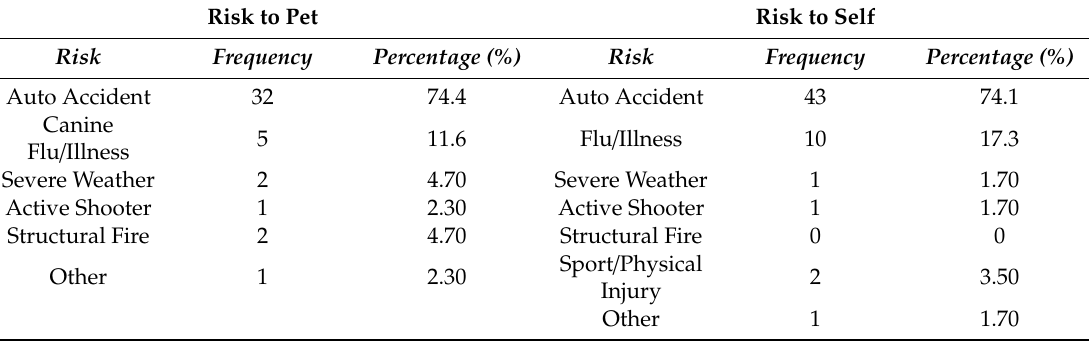
Table 1. Survey responses to “highest risk to self” and “highest risk to